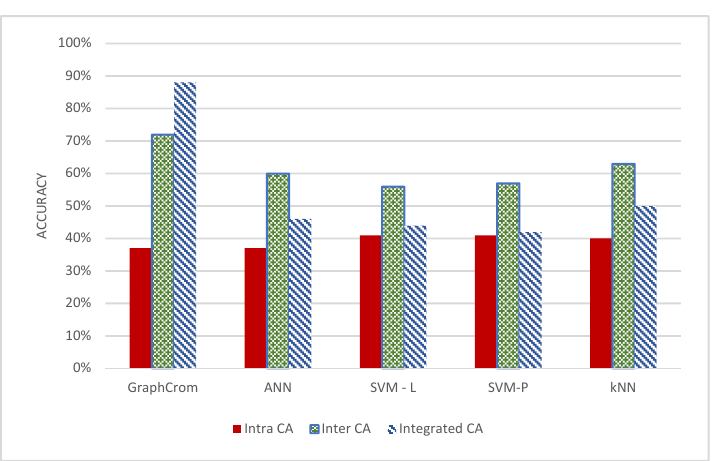
Figure 5. Performance of GraphChrom, vanilla neural network, SVM, and kNN based on inter-, intra-, and integrated chromosomal rearrangement endpoints.